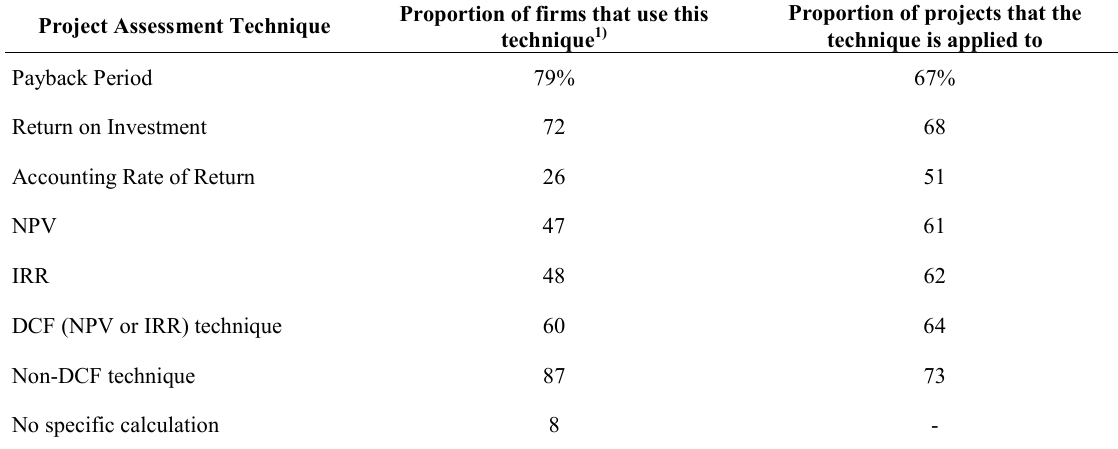
Table 2: Techniques used to evaluate capital expenditure projects Project Assessment Technique